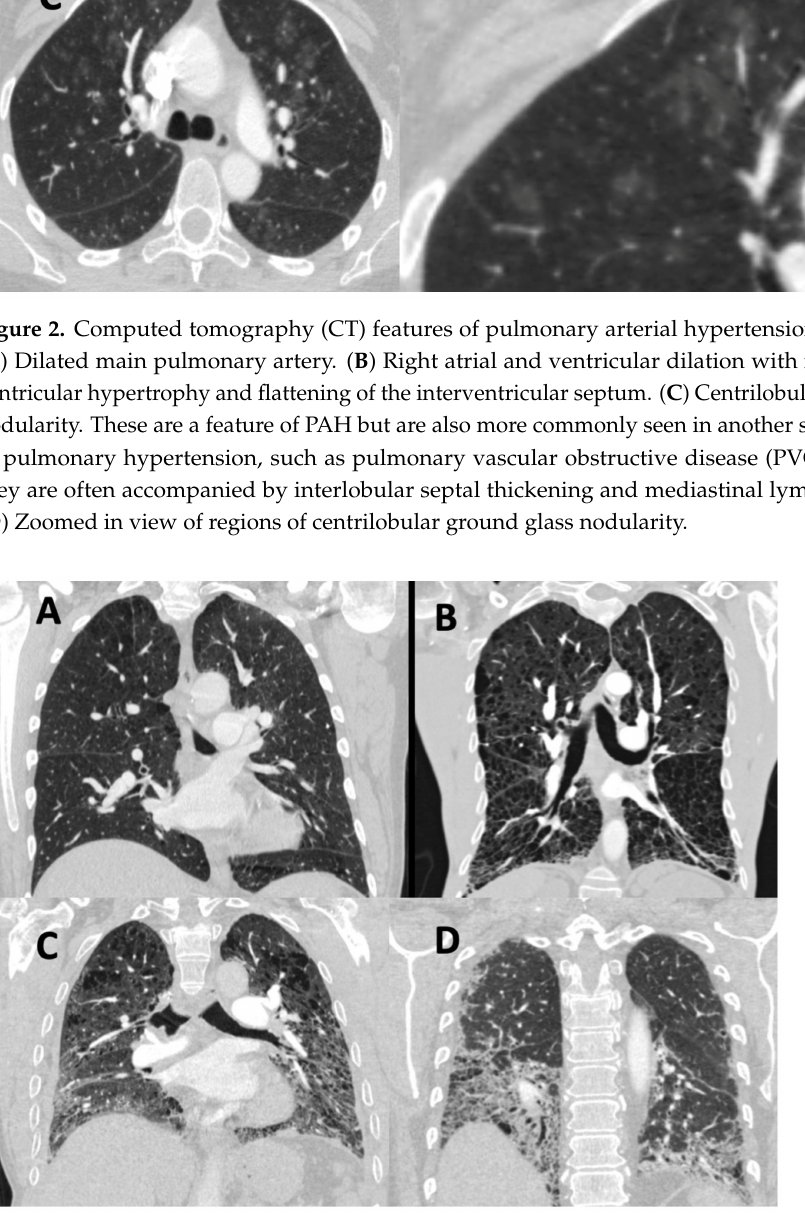
Figure 3. Patterns of lung disease in pulmonary hypertension in association with lung disease and/or hypoxia (PH-Lung) as visualized on CT. ( A ) Mild emphysema localized predominantly to the upper lobe. ( B ) Widespread severe emphysema. ( C ) Combined emphysema and fibrosis. ( D ) Interstitial lung